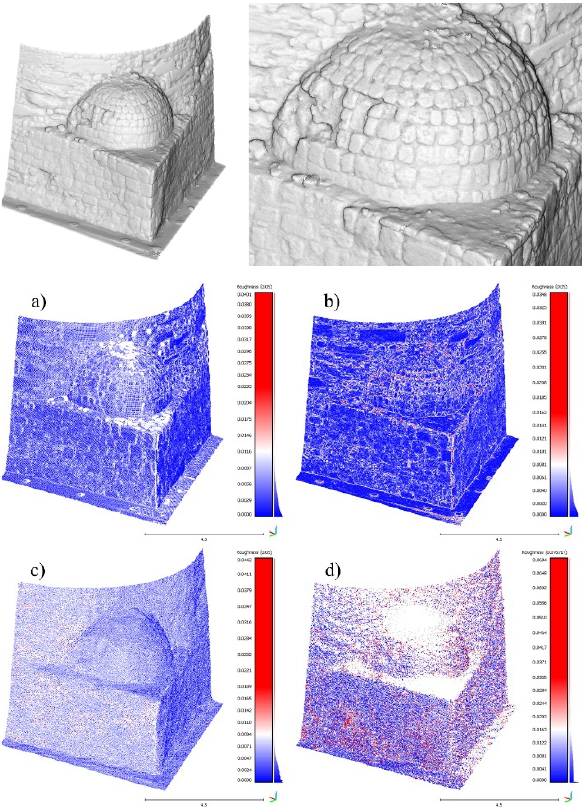
best fitting plane computed on its nearest neighbours (Figure 9).